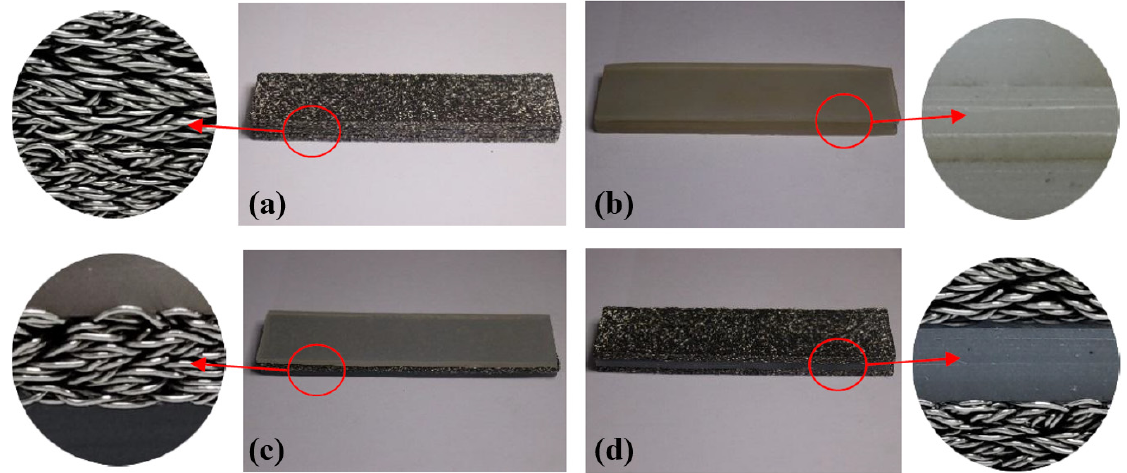
Figure 6. MR/SR laminated structures: ( a ) M-M-M laminated structure; ( b ) S-S-S laminated structure; ( c ) S-M-S laminated structure; ( d ) S-M-S laminated structure.